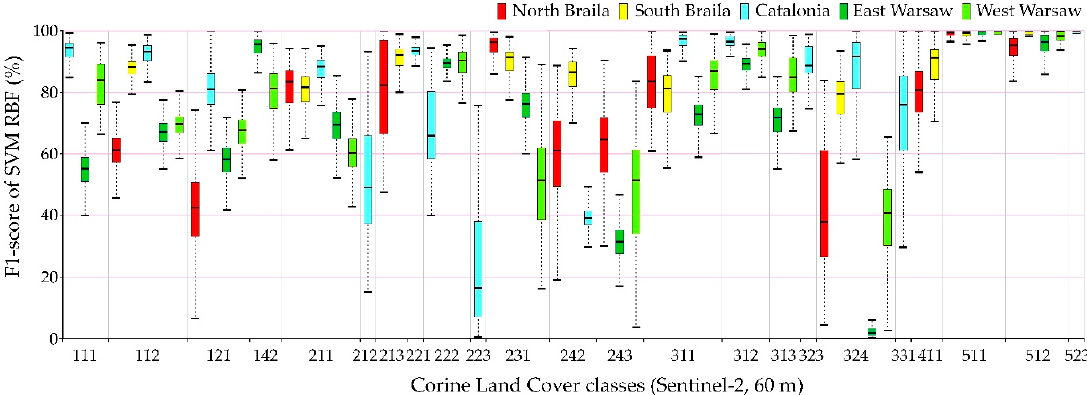
Figure 8. Reference Corine LC map and outcomes of different classification sets and algorithms.